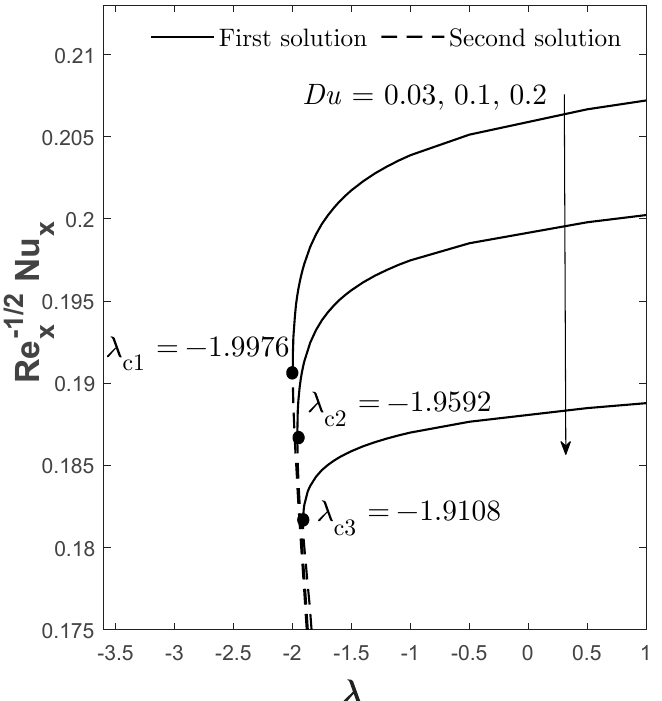
Figure 6. 1/2 Re for varied Du when x Figure 6. Re − 1/2 x Nu x for varied Du when N = Rd = Sc = Sr = 1, φ 2 = 0.01, and Bi = 0.1. Figure 6.